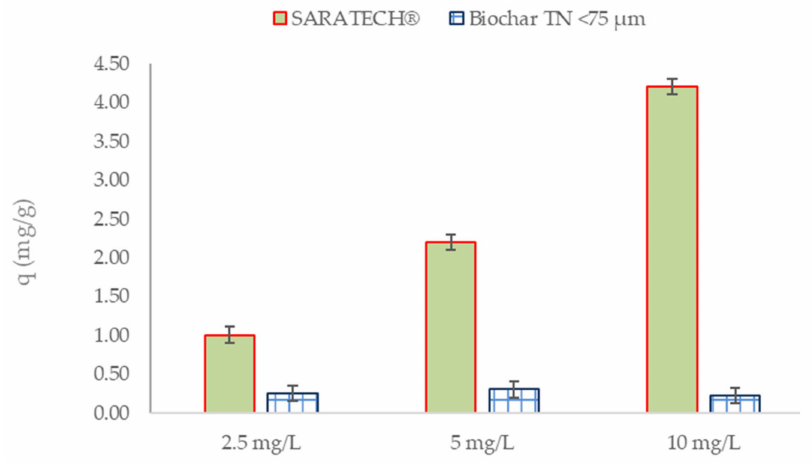
Figure 8. Effect of initial CBZ concentration on the adsorption capacity of Biochar TN < 75 µ m and the activated carbon from SARATECH ® .